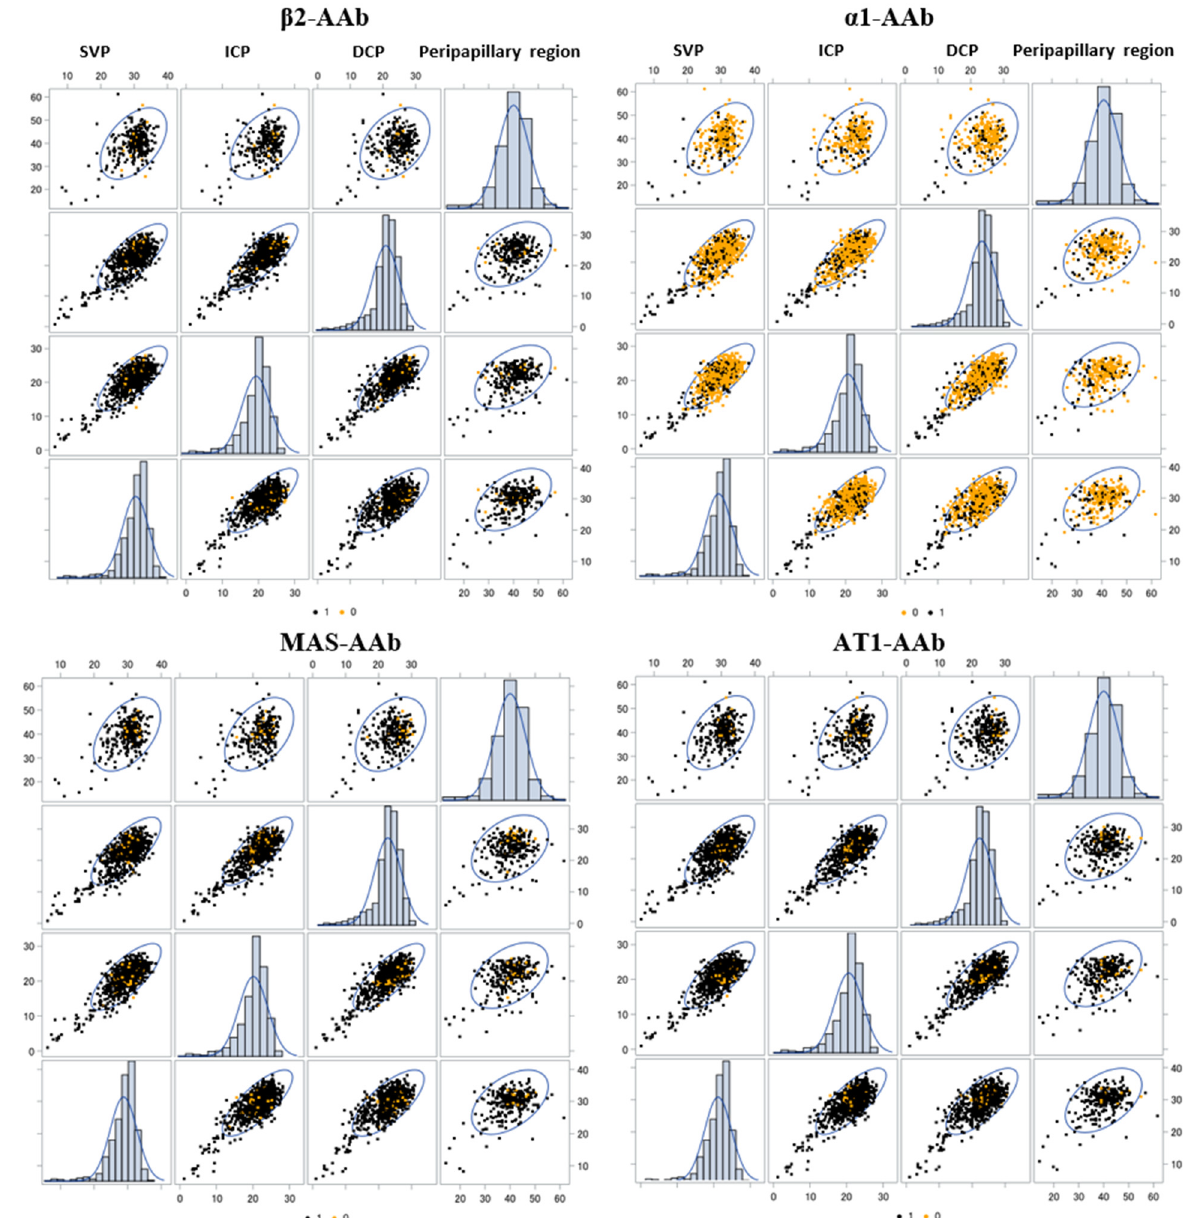
Figure 2. Vessel density in relation to seropositivity and seronegativity of specific autoimmune antibodies. Association between the vessel densities of the SVP, ICP, DCP, and peripapillary region of patients with Long COVID considering a seropositivity of β 2-AAb, α 1-AAb and MAS-AAb with the 95% prediction ellipse. Black = Seropositivity (1), Yellow = Seronegativity (0); SVP—superficial vascular layer; ICP—intermediate capillary plexus; DCP—deep capillary plexus.